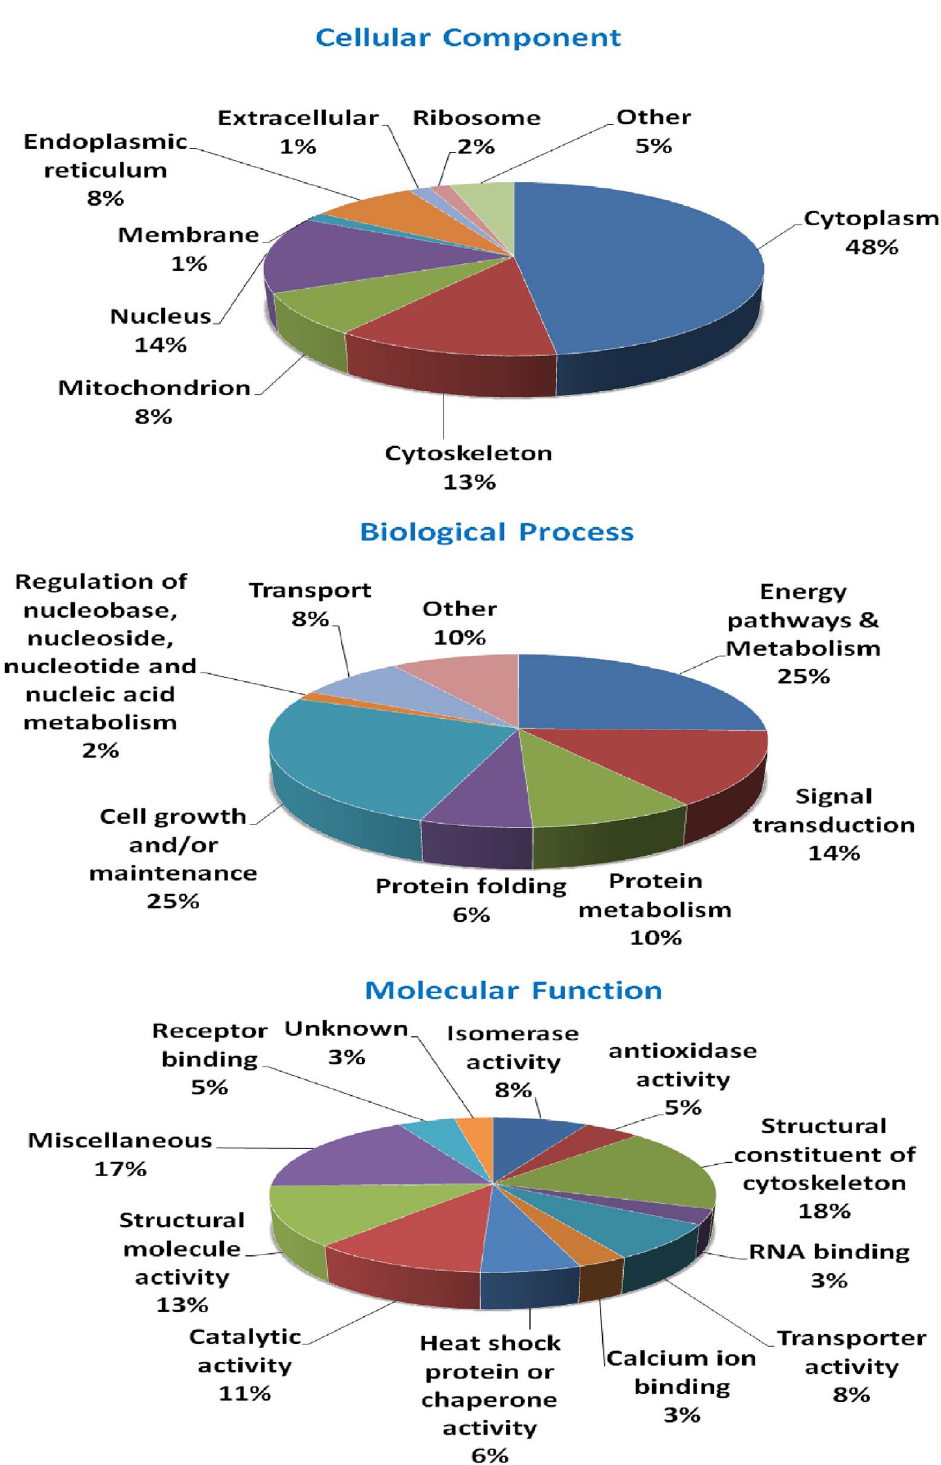
Figure 5. Gene ontology (GO) analysis of differentially expressed proteins among fibroblasts, f-rES, and p-rES cells. The official gene symbols of differentially expressed proteins are used for the GO annotations. Original GO annotations for cellular components, molecular functions, and biological processes are based on the NCBI Entrez Gene database for classification. The percentages represent the total hits divided by the number of annotated proteins within each category.